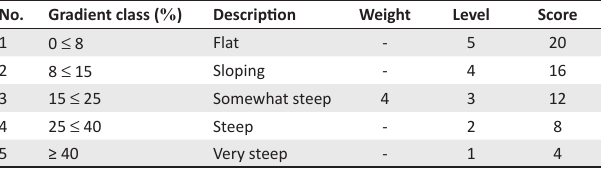
TABLE 4: Slope classification.